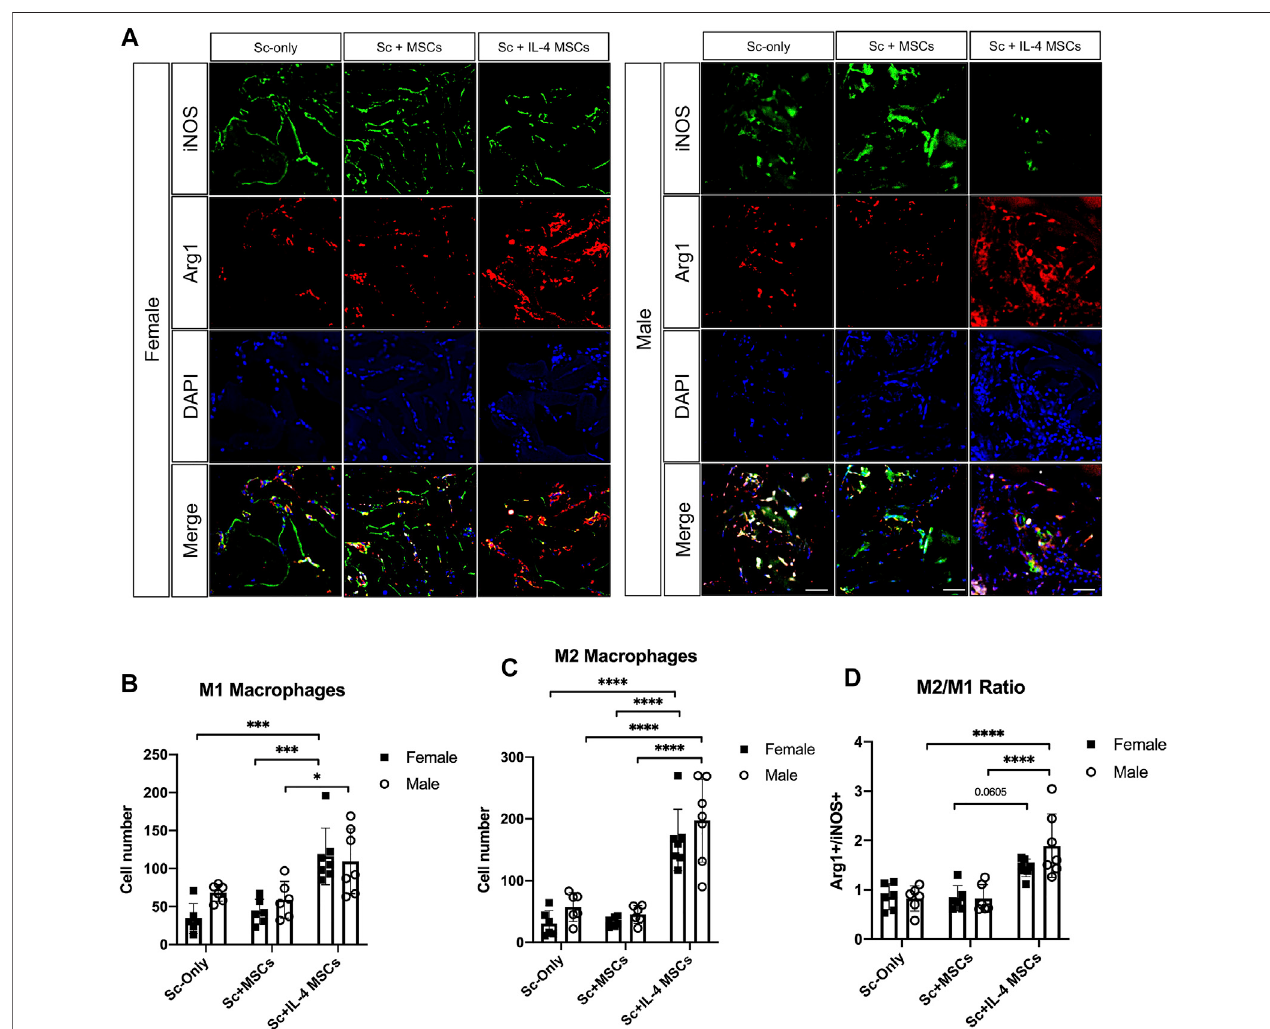
FIGURE 7 | Immunohistochemistry staining and analysis of iNOS/Arg1/DAPI inside the scaffolds of critical size bone defect healing after 6 weeks in female and male mice. (A) Representative images of iNOS/Arg1/DAPI stained macrophages in all groups. (Blue: DAPI/nucleus; Green: iNOS/M1 macrophage marker; Red: Arg-1/ M2macrophagemarker.Bar (cid:2) 50 µm). (B) Numberofcellscountedfromtheimmunohistochemistryimages.FemaleSc-only, n (cid:2) 6;femaleSc+MSCs, n (cid:2) 6;femaleSc + IL-4 MSCs, n (cid:2) 7; male Sc-only, n (cid:2) 6; male Sc + MSCs, n (cid:2) 6; male Sc + IL-4 MSCs, n (cid:2) 7. *: 0.01 ≤ p < 0.05, ***: 0.0001 ≤ p < 0.001, ****: p < 0.0001.